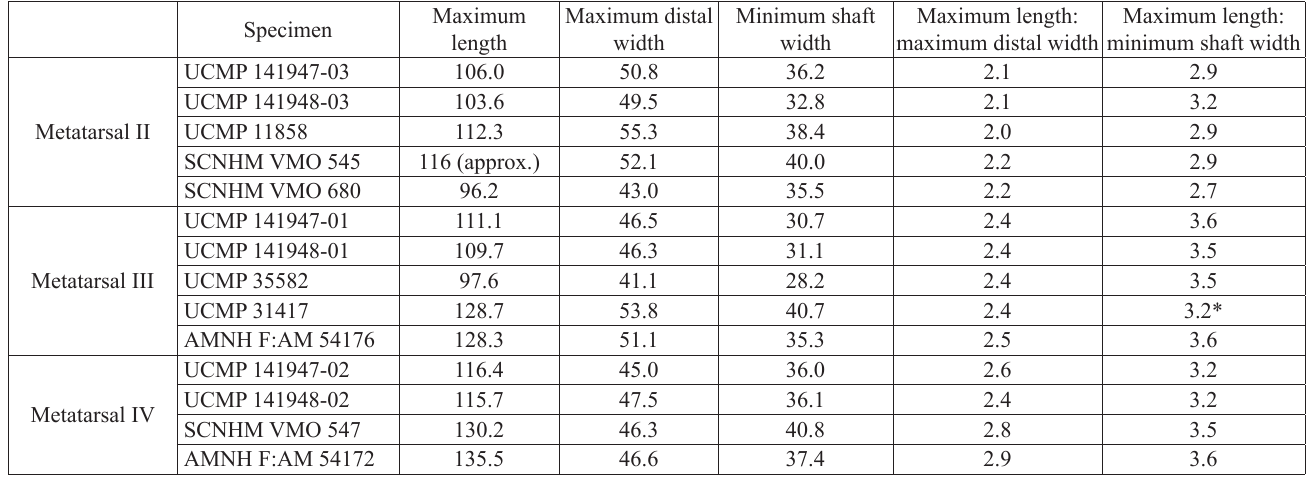
Table 3. Measurements (in mm) and proportions of metatarsals referable to Moropus merriami . UCMP 141947 (left) and UCMP 141948 (right) from Eastgate probably belong to one individual. Compare proportions with Coombs (1978: table 6, 1979: table 8, 2004: table 1). * corrected from Coombs